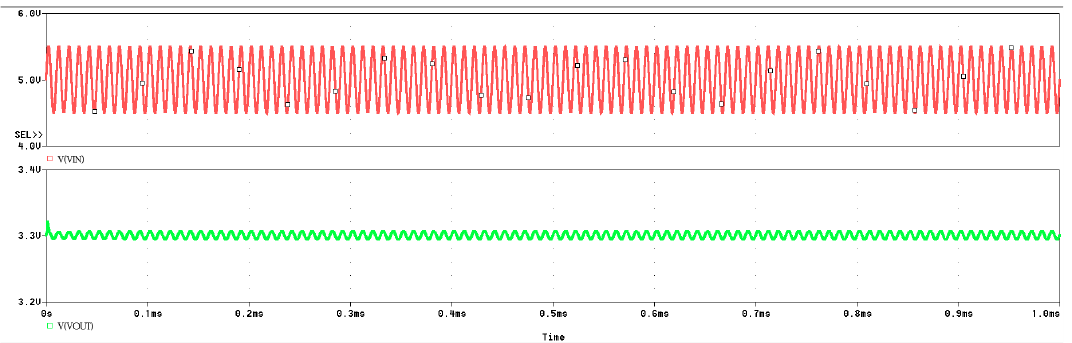
Figure 15. PSRR simulation waveforms at 100 kHz. Table 1. Simulated new PSRR vs.